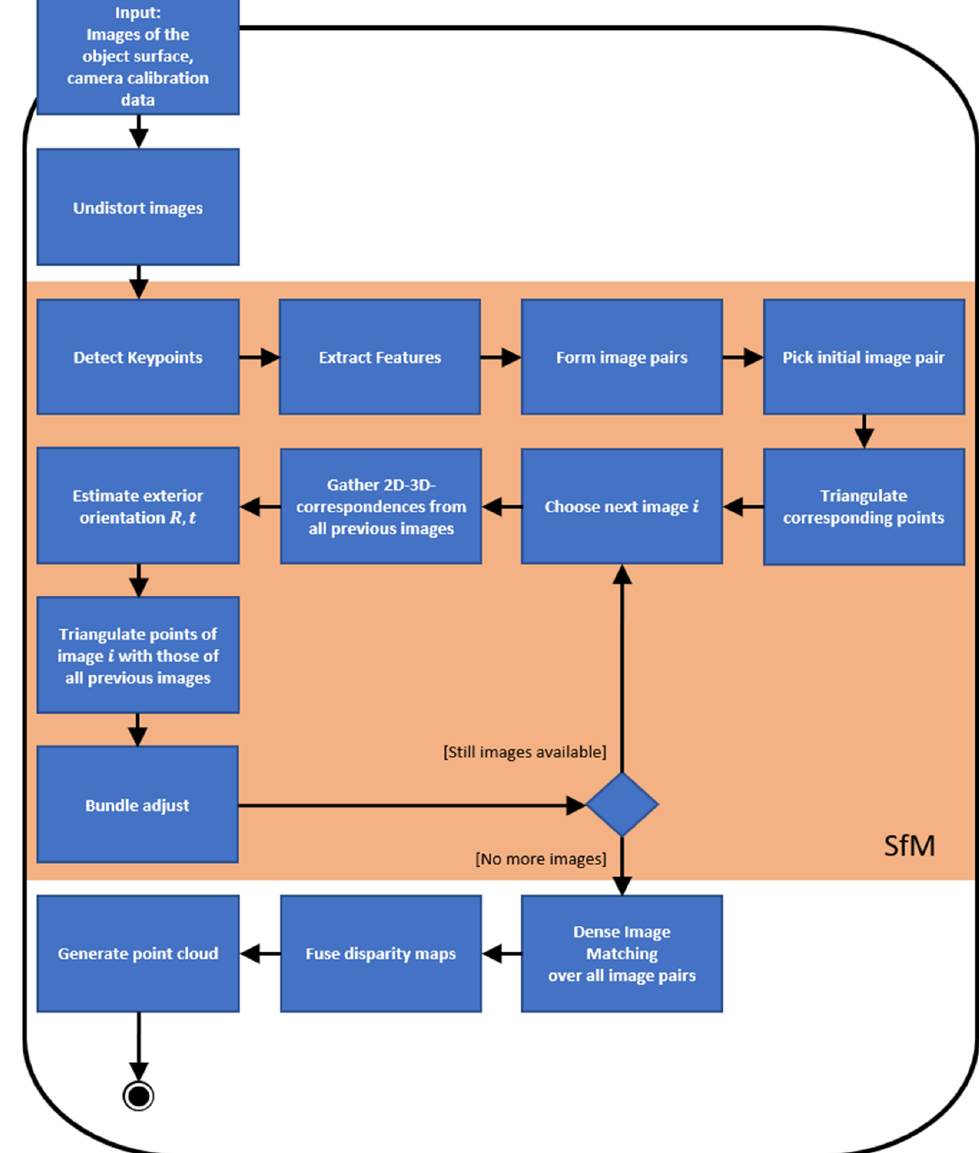
Figure 8. The incremental 3D reconstruction pipeline.